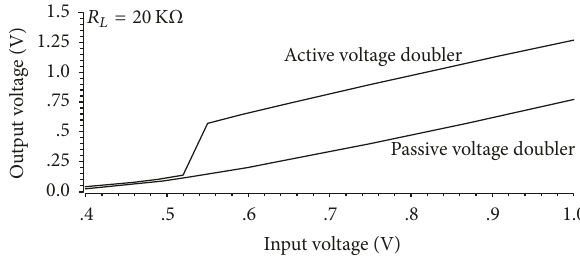
Figure 8: Simulated output voltage with respect to input voltage.